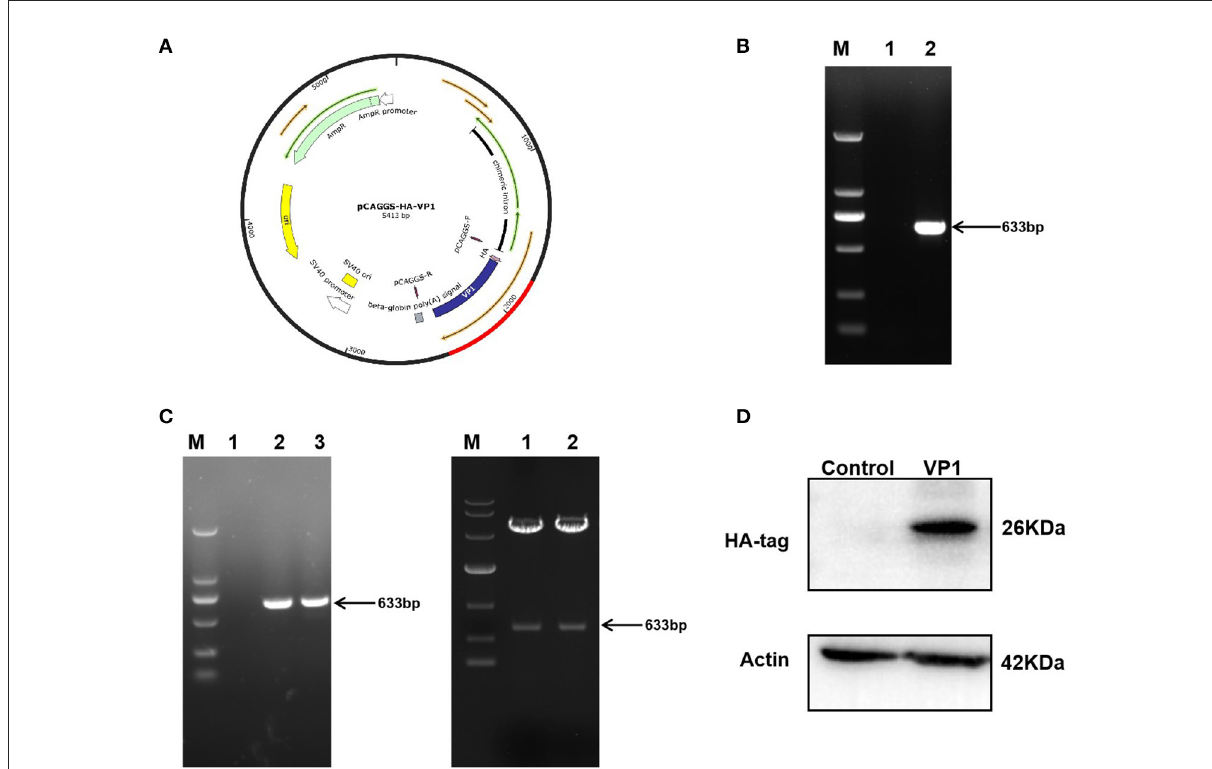
FIGURE1 Construction and expression of pCAGGS-HA-VP1 Plasmid. (A) Model of a cloned fragment. (B) Target fragment VP1 amplified by PCR (lane 2), respectively. (C) The product of recombinant plasmid pCAGGS-HA-VP1 verified by colony PCR (lanes 2 and 3 on the left panel) and digested with EcoR1 and Xho1 (lanes 1 and 2 on the right panel) was observed with agarose gel electrophoresis. (D) The pCAGGS-HA vectors (control) or pCAGGS-HA-VP1 plasmids were transfected in PK-15 cells for 36h, respectively, and detected by western blot